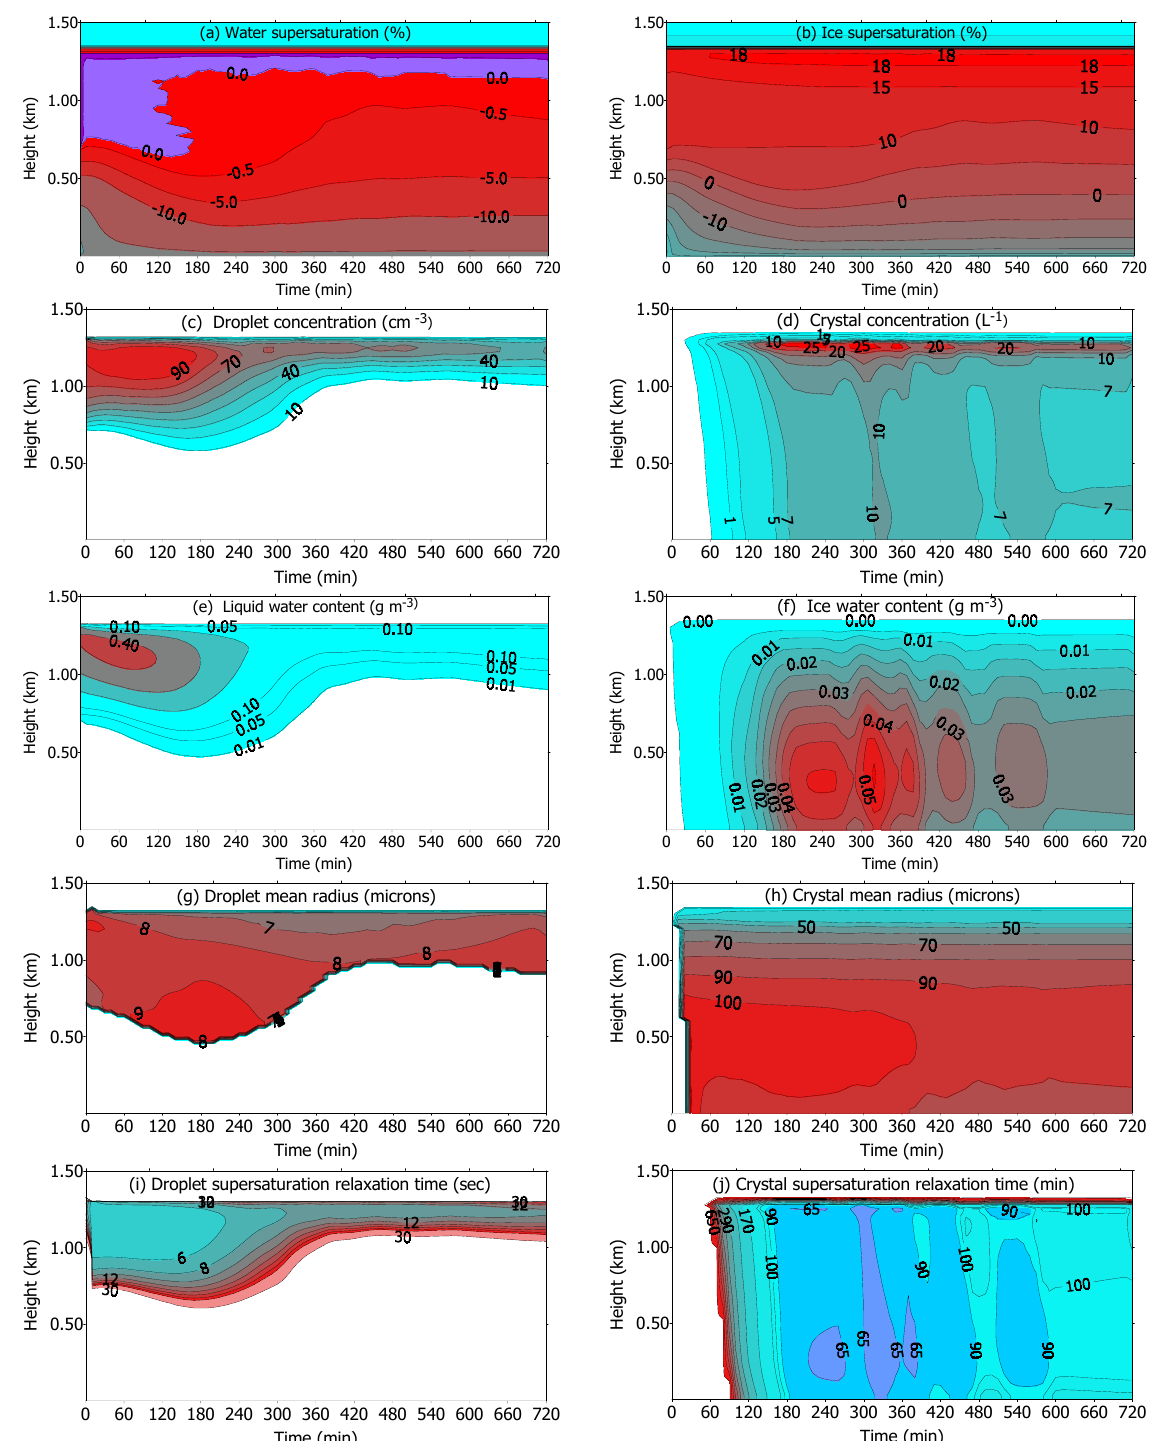
Fig. 7. Evolution of the Arctic mixed-cloud microphysical properties over 12h with initial M-PACE data on 10 October 2004, KC ice scheme with deliquescence-heterogeneous-freezing (DHetF) mode only and KC06-07 drop activation scheme. In this simulation, the aerosol of the fine observed lognormal mode ( N a1 = 72 . 2cm − 3 , r m = 0 . 052µm, σ 1 = 2 . 04) was allowed to serve as CCN; the aerosol of the coarse observed lognormal mode ( N a2 = 1 . 8cm − 3 , r m = 1 . 3µm, σ 2 = 2 . 5) was allowed to serve as ice nuclei and participate in nucleation